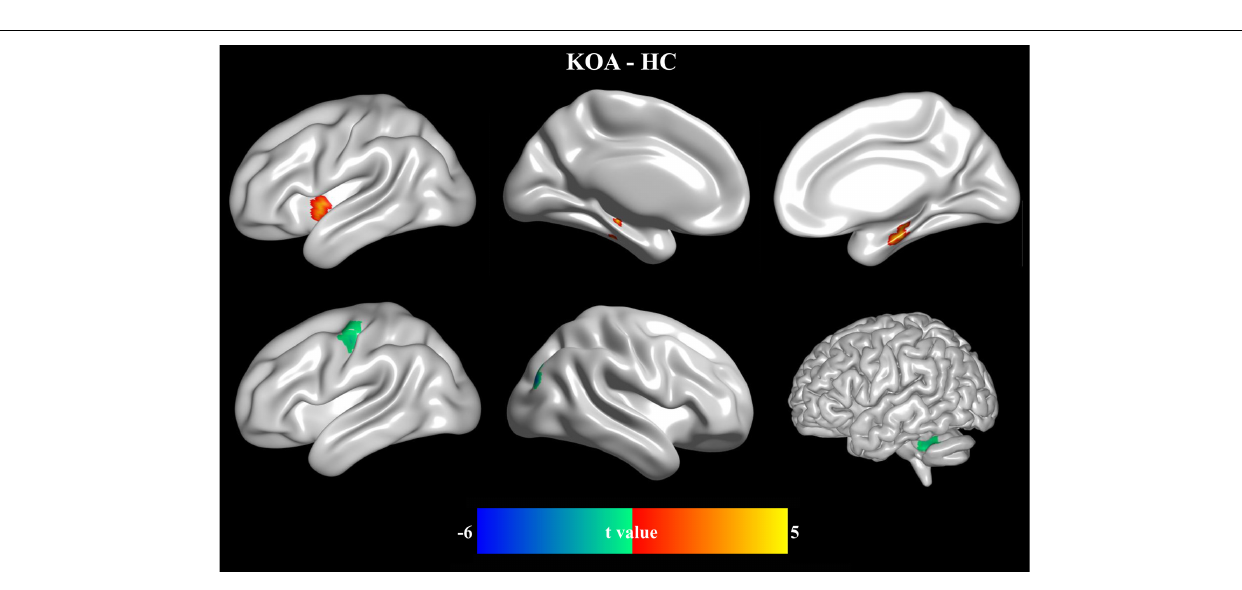
FIGURE 3 | Abnormal resting-state functional activities in patients with KOA. Comparing with HC, the patients with KOA showed higher fALFF in left insula and bilateral hippocampus while lower fALFF in left precentral gyrus, left cerebellum, and right superior occipital